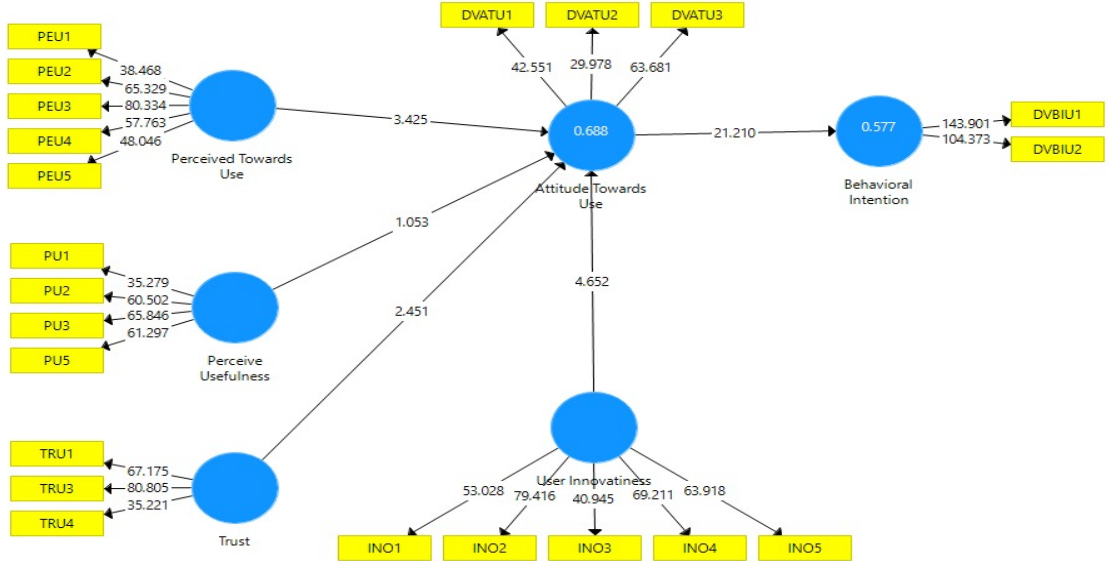
Figure 4. Assessment of the structural model.